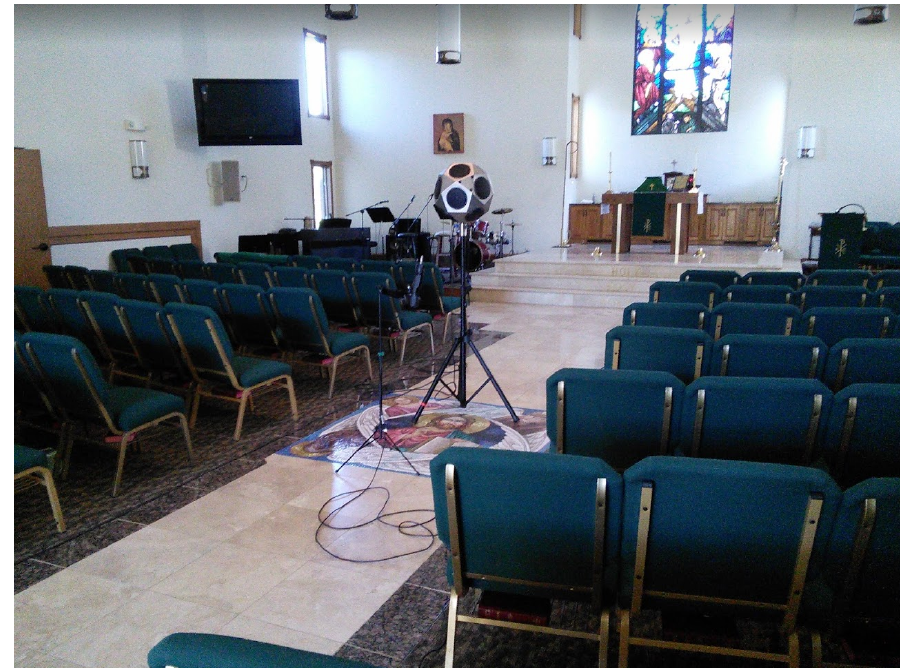
Figure 2. Brüel and Kjær TYPE 4292-L dodecahedral loudspeaker in the source location used for measurements.